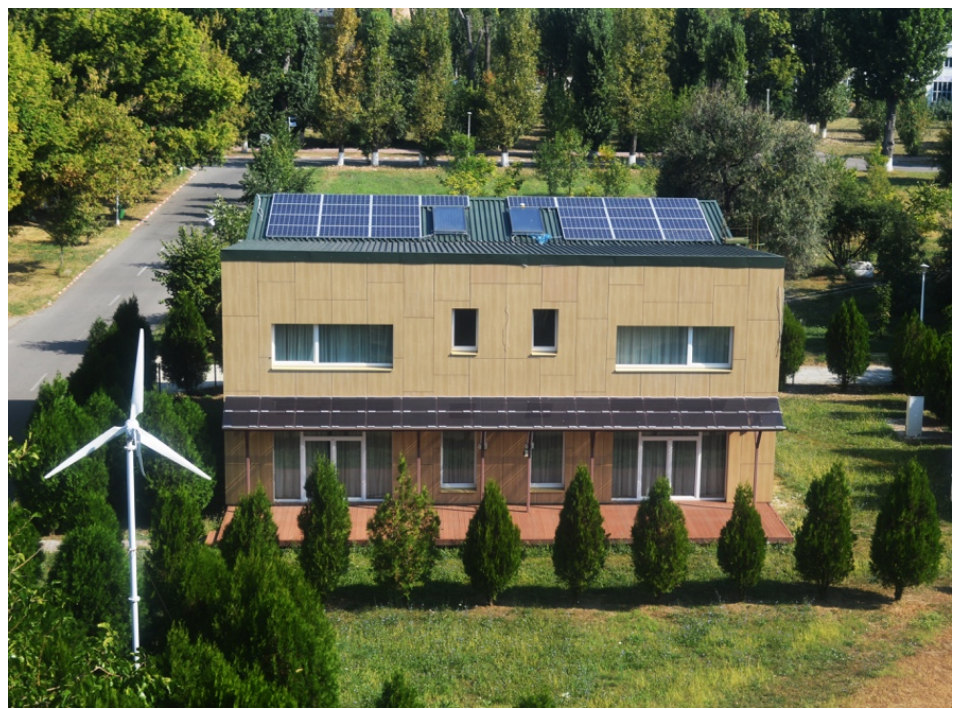
Figure 5. West ( right ) and east ( left ) passive house—South facade.